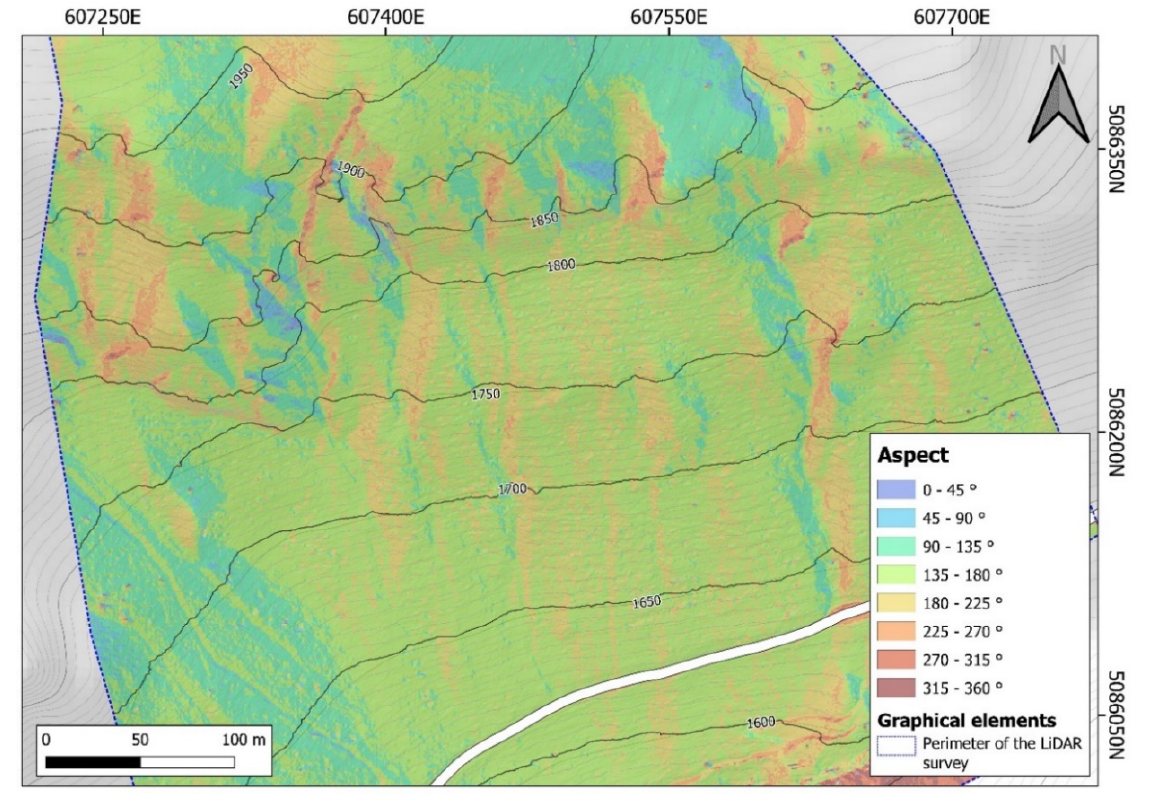
Figure 6. Exposition (aspect) of the entire study area; the average value is SSE. For the rock faces in the upper portion of the slope, the variation is much more significant, with sectors facing ENE to NNE.